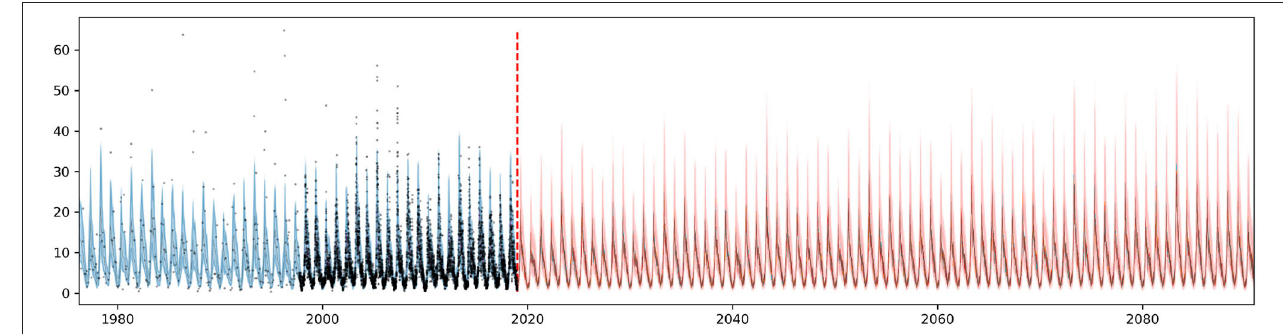
FIGURE 11 | Long term chlorophyll-a concentration time series projection with radiation and temperature explanatory variables from generated climate projections (based on EURO-CORDEX). One hundred and twenty solar radiation and air temperature projection scenarios were used to produce the 120 chlorophyll-a trajectories. Model fit between 1976 and 2018 (blue) and projection between 2019 and 289 (red). Predictive uncertainty in shaded area.